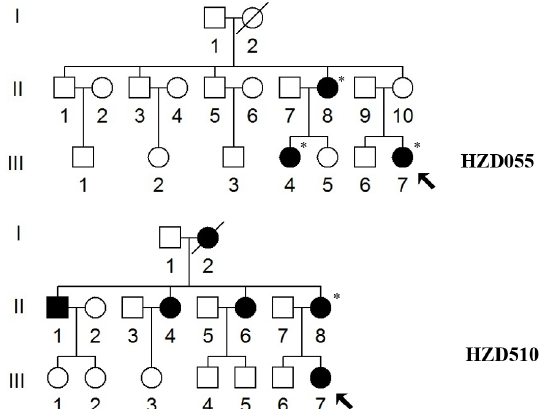
Figure 1. Two Han Chinese pedigrees with AINSHL. Arrows indicate the probands, * indicates the individuals who had a history of using AmAn. In addition, pure-tone audiometry (PTA) was carried out in a sound-controlled room at frequencies ranging from 250 to 8000 Hz, as suggested in our recent study [24]. The levels of hearing loss were divided into five grades: normal: < 20 decibels (dB); mild: 20– 40 dB; moderate: 41–70 dB; severe: 71–95 dB; and profound > 95 dB, according to the study as previously described [25].